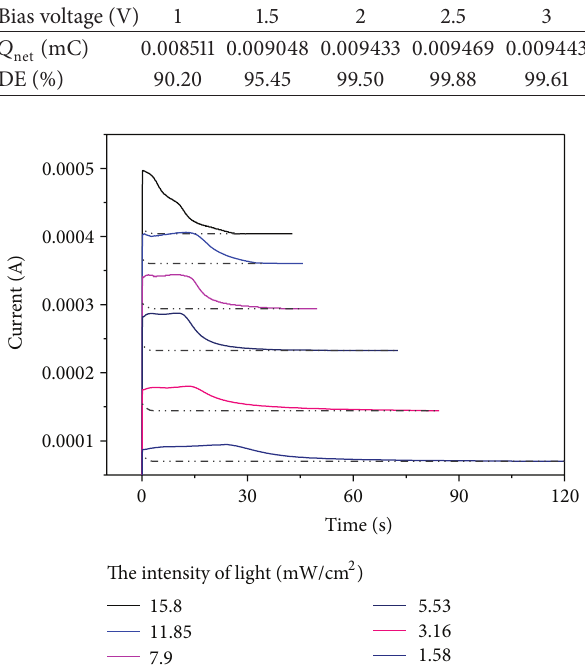
Figure 4: Photocurrent responses of a 2mol/L NaNO 3 blank solu- tion containing benzoic acid (0.4mmol/L) in the thin-cell reactor based on the TNA electrodes at the fixed applied bias potential of 2.5 V under different light